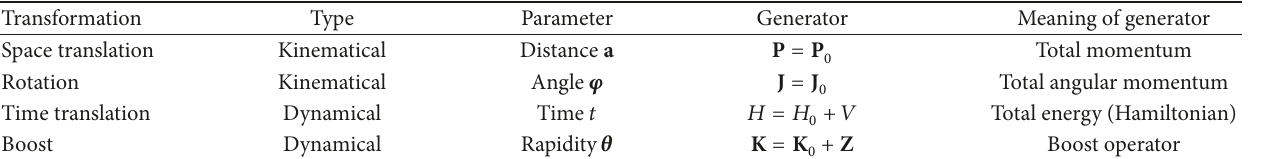
Table 1: Inertial